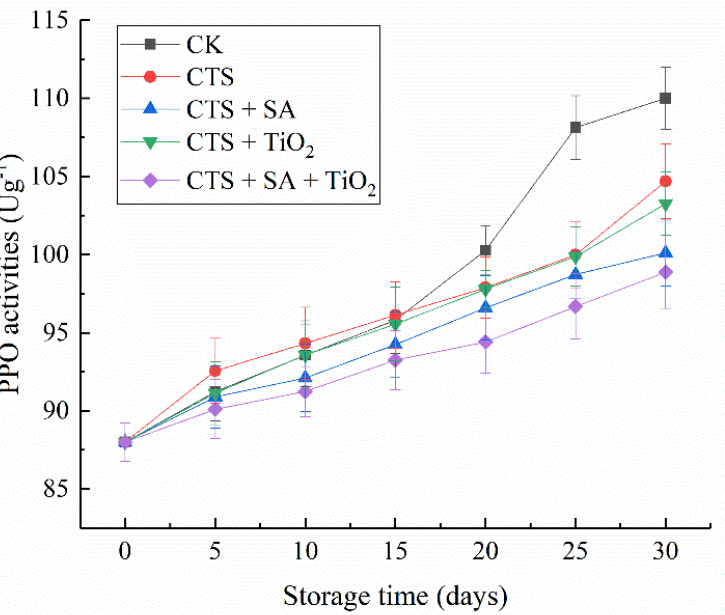
Figure 4. Effect of different coatings on the PPO activity in the blackcurrant during 30-day storage at 4 °C.